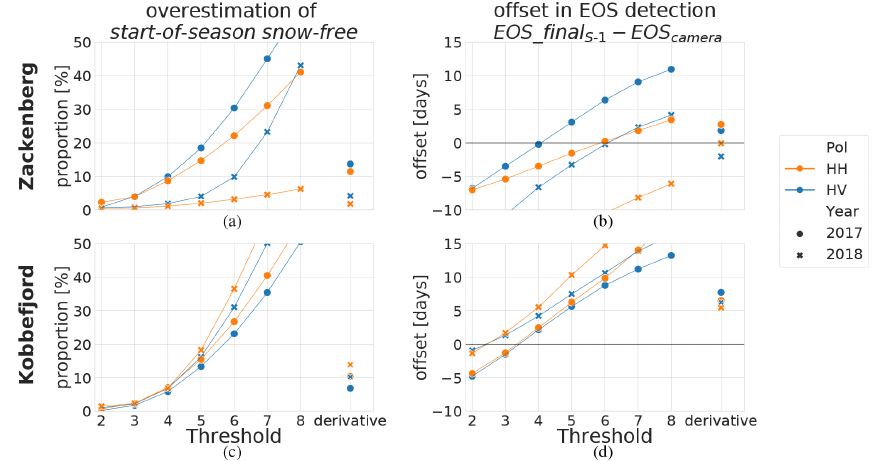
Figure 10. The key snow cover (SC) mapping accuracy parameters influenced by the threshold and polarization setting are (a, c) overestima- tion of start-of-season snow-free areas for higher thresholds leading to an underestimation of SC in early melt season and (b, d) a negative offset in mean EOS for low thresholds leading to underestimation of SC in late melt season.